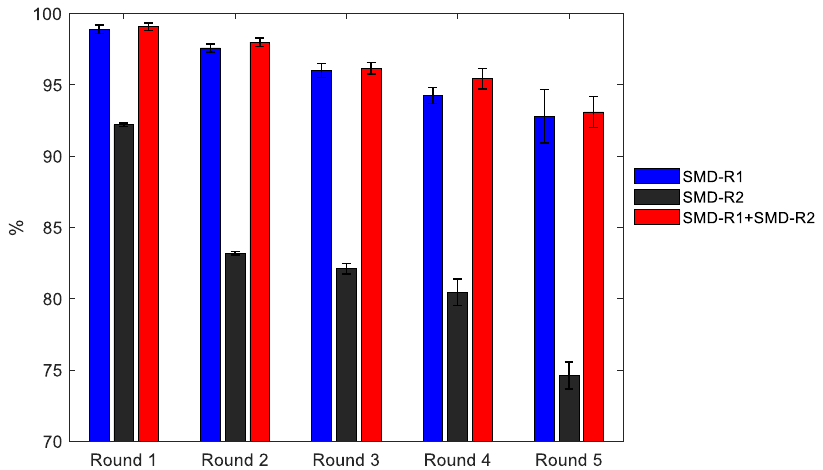
Figure 15. Testing accuracy on the testing dataset for five consecutive rounds, with dynamic feature selection over 20 independent runs.